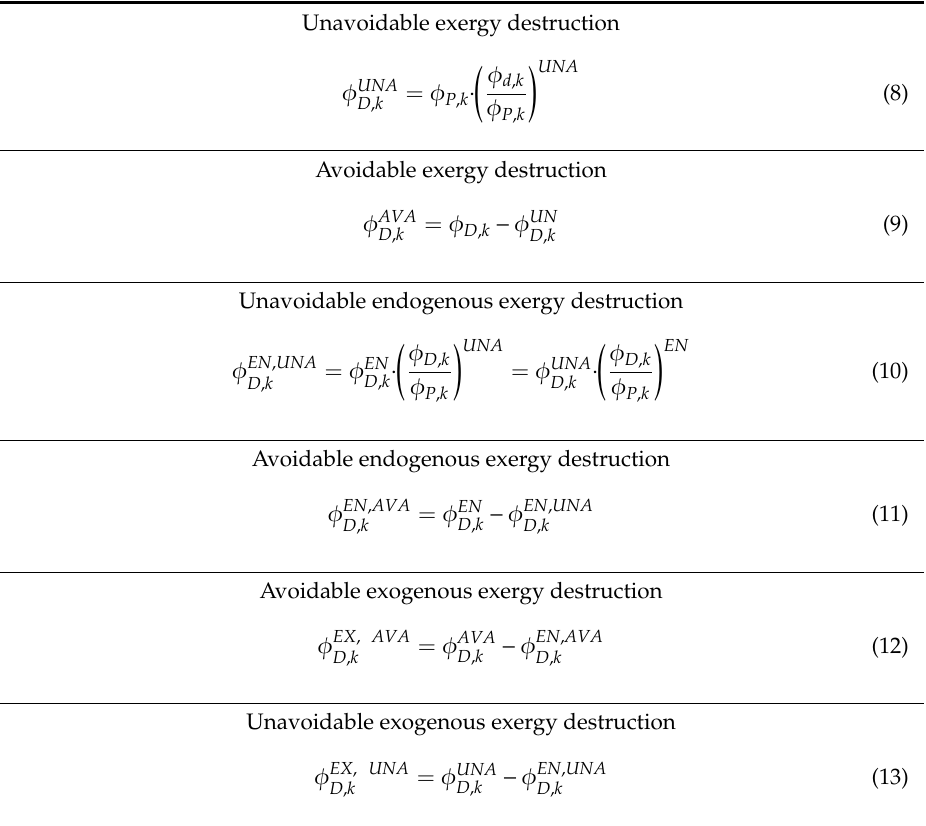
Figure 2. Outline of advanced exergetic analysis. Table 2. Equations of advanced exergetic